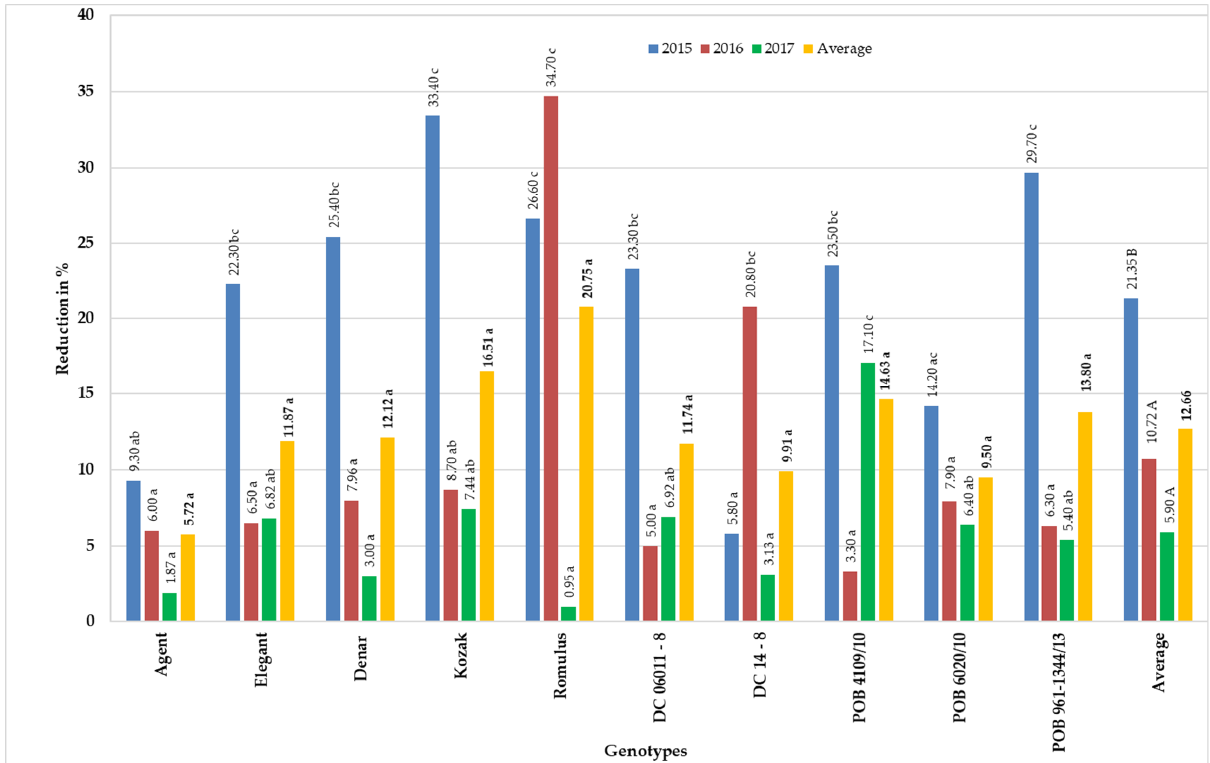
Figure 5. Reduction of 1000 kernels weight after panicle inoculation with F. equiseti , compared to control. The values obtained within an individual year for all genotypes, marked with the same letter do not differ significantly at p ≤ 0.05. The average values obtained for all genotypes over the three years of study (yellow columns), marked with the same letter, do not differ significantly at p ≤ 0.05.